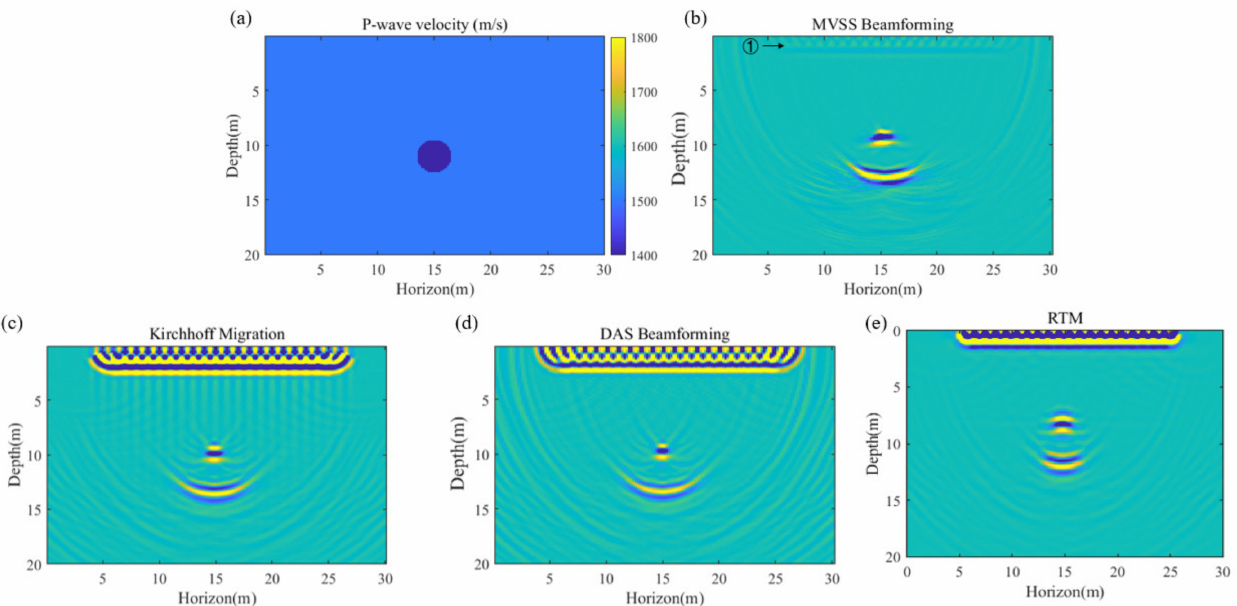
Figure 10. Model A-1. ( a ) True velocity model. ( b ) Imaging result of MVSS beamforming. ( c ) Imaging result of Kirchhoff migration. ( d ) Imaging result of DAS beamforming. ( e ) Imaging result of RTM.